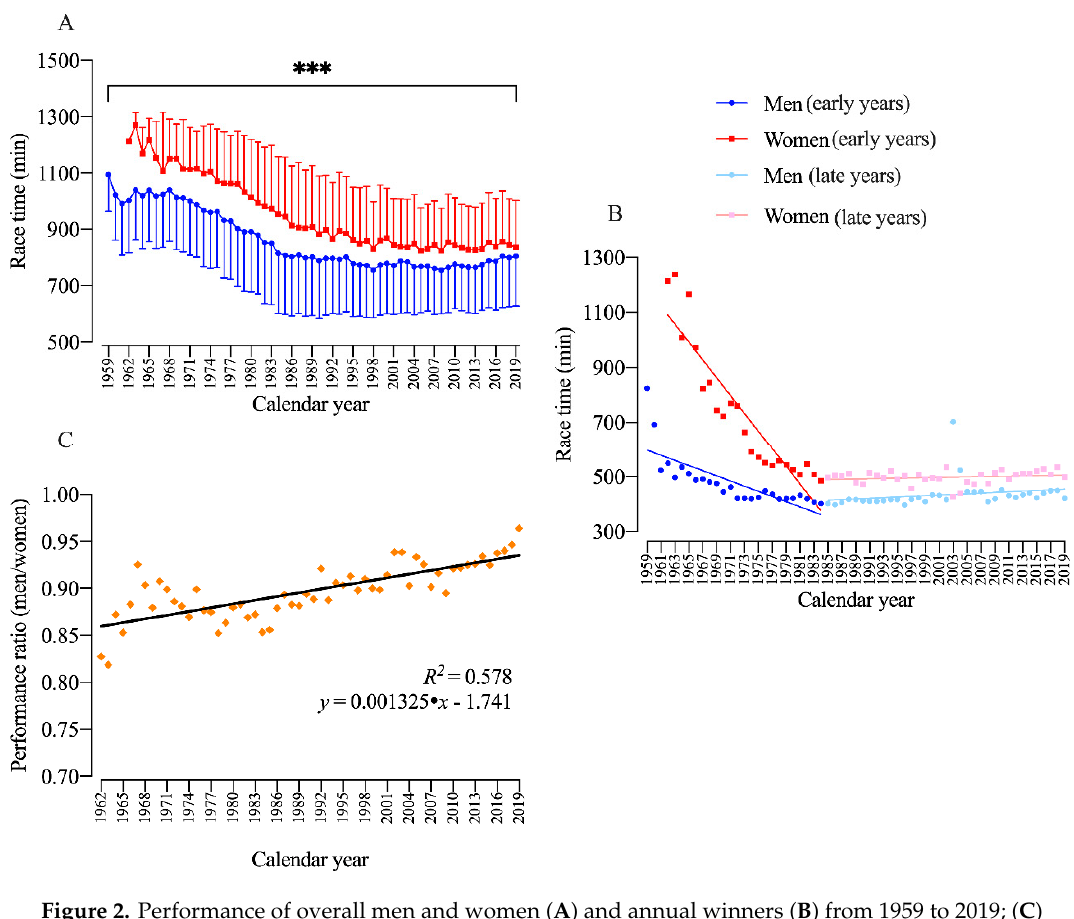
Figure 2. Performance of overall men and women ( A ) and annual winners ( B ) from 1959 to 2019; ( C ) Performance ratio during the same period. ***: sex, age and interaction effect ( p < 0.05).